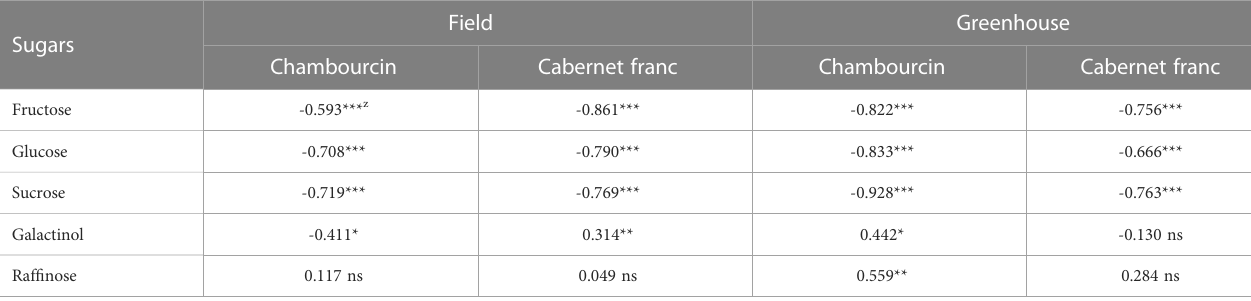
TABLE 3 Correlations between soluble sugar concentrations and freezing tolerance (LT50) of grape buds.